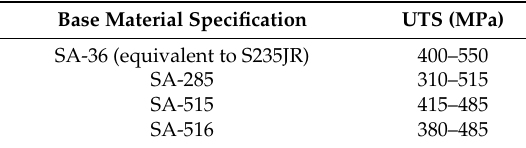
Table 3. Definition of parameters used for each sample and results. Table 6. Ultimate Tensile Strength of typical base materials welded with ER70S-6 according to SFA 5.18 [49].